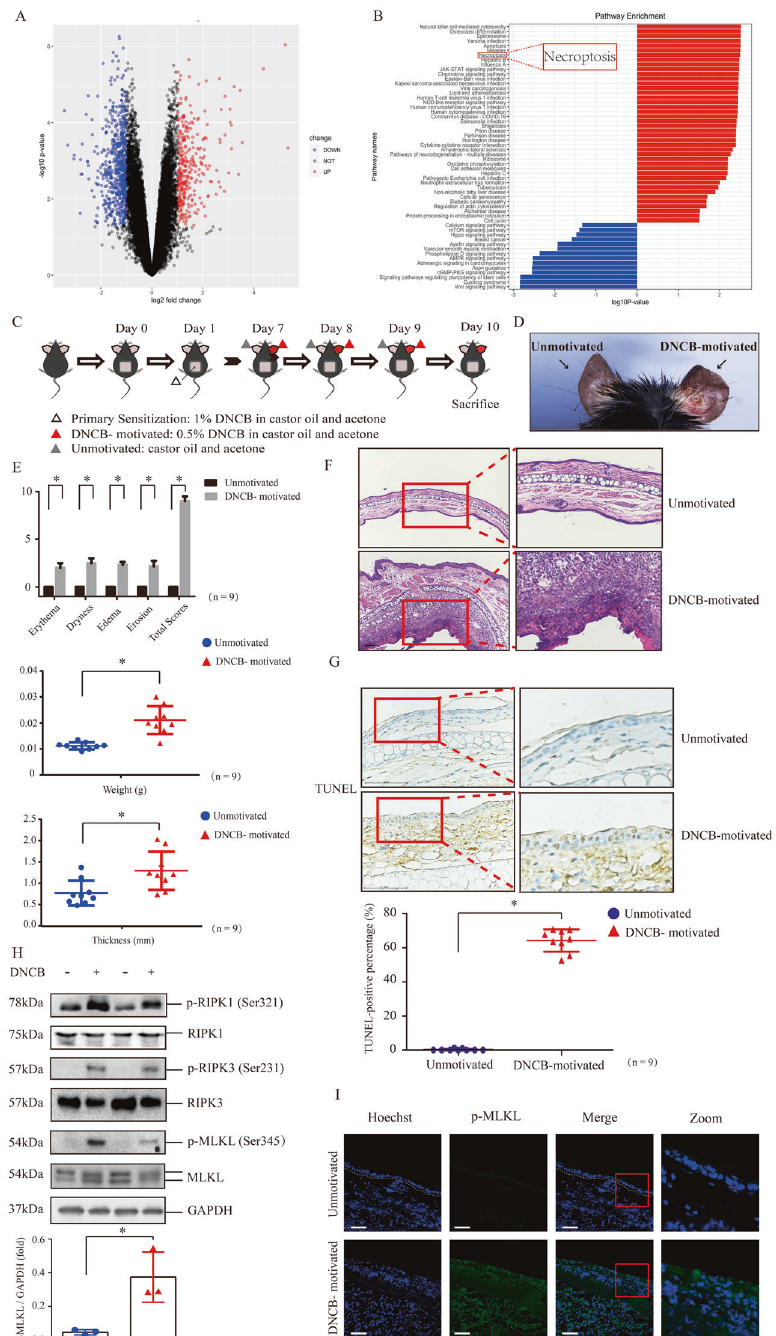
Fig. 1 Necroptosis core modulators are activated in keratinocytes in CHS murine model. A Volcano plot displaying differential expressed genes between skin lesions and non-lesions of ACD patients based on Pedersen MB et. al ’ s study [13]. B KEGG pathway analysis of the differential expressed genes. Annotation clusters are shown according to their enrichment scores [log10 ( p -value)]. C Flowchart of CHS murine model. D The skin appearance of DNCB-motivated CHS model. Left ear was the sample of unmotivated tissue, and right ear was motivated by DNCB. E The severity of skin manifestation in the CHS mice was evaluated by Dermatitis Score, ear weight and thickness. ( n = 9). F The histological features were showed by the tissue section staining with Hematoxylin and Eosin (H&E, 20× magni fi cation). G The level of keratinocyte death was determined by TUNEL staining. ( n = 9). Scale bar represents 100 μ m. H The protein level and phosphorylation of RIPK1, RIPK3 and MLKL were detected by western blotting. GAPDH served as the loading control. Statistical analysis of the interested protein was shown ( n = 3). I The phosphorylation of MLKL was detected by immuno fl uorescence in the tissue of CHS mice model (green) ( n = 9). Scale bar represents 100 μ m. ∗ p < 0.05.